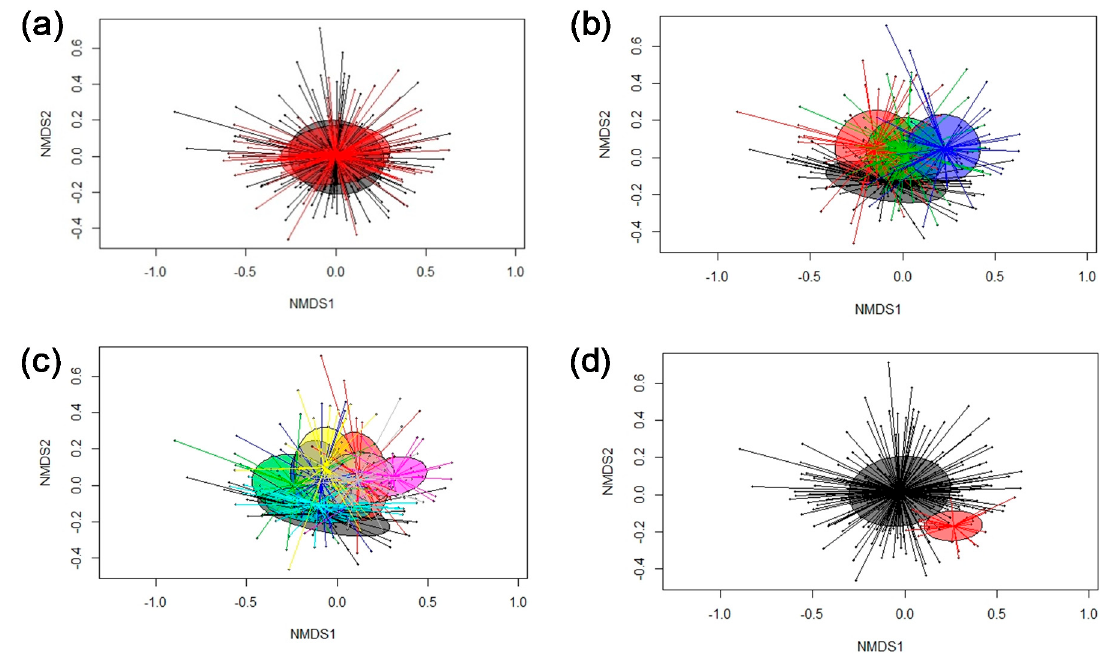
Figure 1. Non-metric multidimensional scaling (NMDS) plot of pairwise Bray–Curtis dissimilarities between bacterial communities in feces of pigs fed diets with (Phy diet) or without phytase (Con diet; stress level = 0.187). ( a ) sex (grey, female; male, red); ( b ) sampling time points (grey, week 0; red, week 3; green, week 5; and blue, week 10); ( c ) diet effect per time point (grey, Con diet week 0; turquoise, Phy diet week 0; green, Con diet week 3; yellow, Phy diet week 3; blue, Con diet week 5; red, Phy diet week 5; withish, Con diet week 10; pink, Phy diet week 10); and ( d ) ‘community type cluster (grey, cluster A; red, cluster B). Ellipses represent the standard deviation.